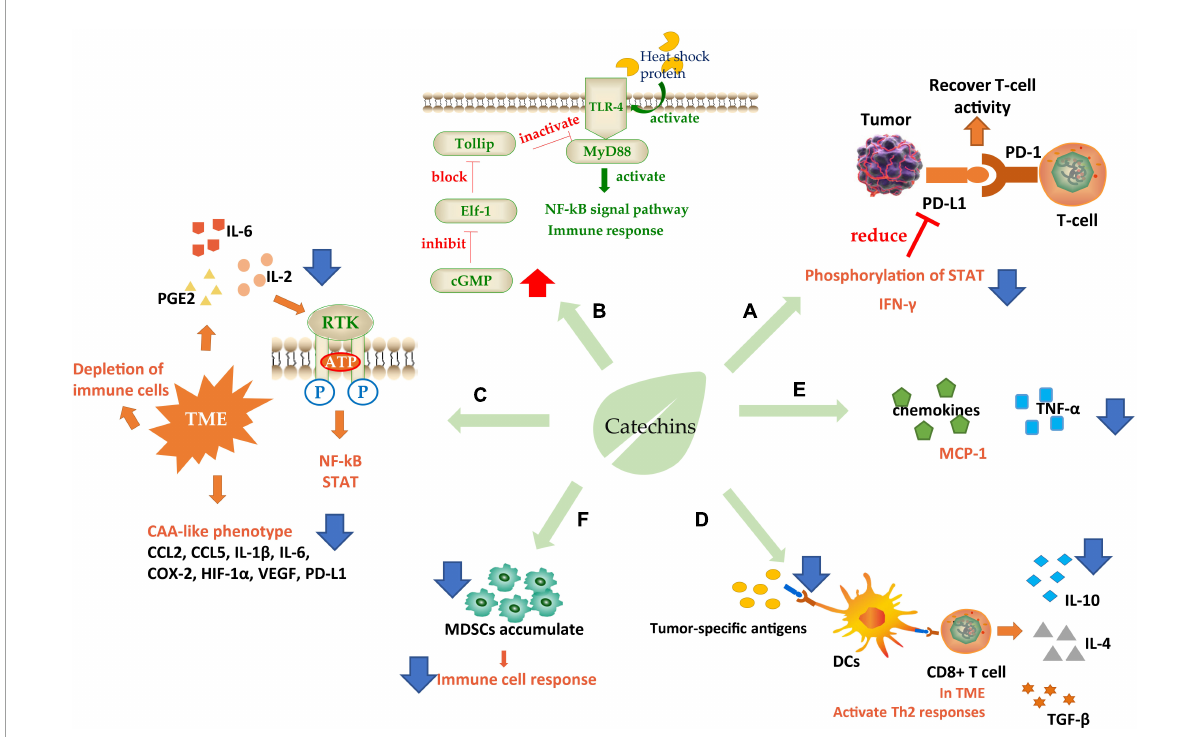
FIGURE3 Schematic diagram of catechins regulating immunity. (A) Increase immune checkpoint function; (B) interaction with TLR-4; (C) ameliorate TME; (D,E) regulates immune cell response; (F) regulated immune cytokines. TLR-4, toll-like receptor 4; TME, tumor microenvironment; DCs, dendritic cells; CAA, cancer-associated adipocyte; MDSCs, myeloid-derived suppressor cells. Blue arrows indicate downregulation and red arrows indicate